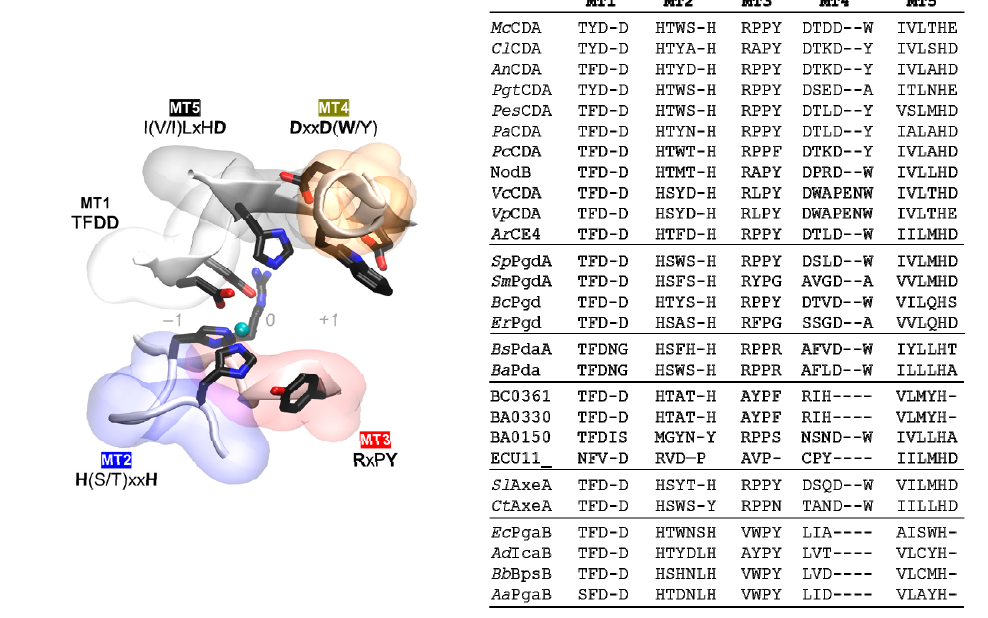
Figure 5. Conserved catalytic motifs MT1–5 of the CE4 family. ( Left ) Spatial disposition in the 3D active site structure; ( Right ) Motif sequences for the enzymes listed in Table 1. Subfamilies separated by a line: CDAs, peptidoglycan GlcNAc deacetylases, peptidoglycan MurNAc deacetylases, unknown, acetylxylan esterases, and poly- β -1,6-GlcNAc deacetylases.